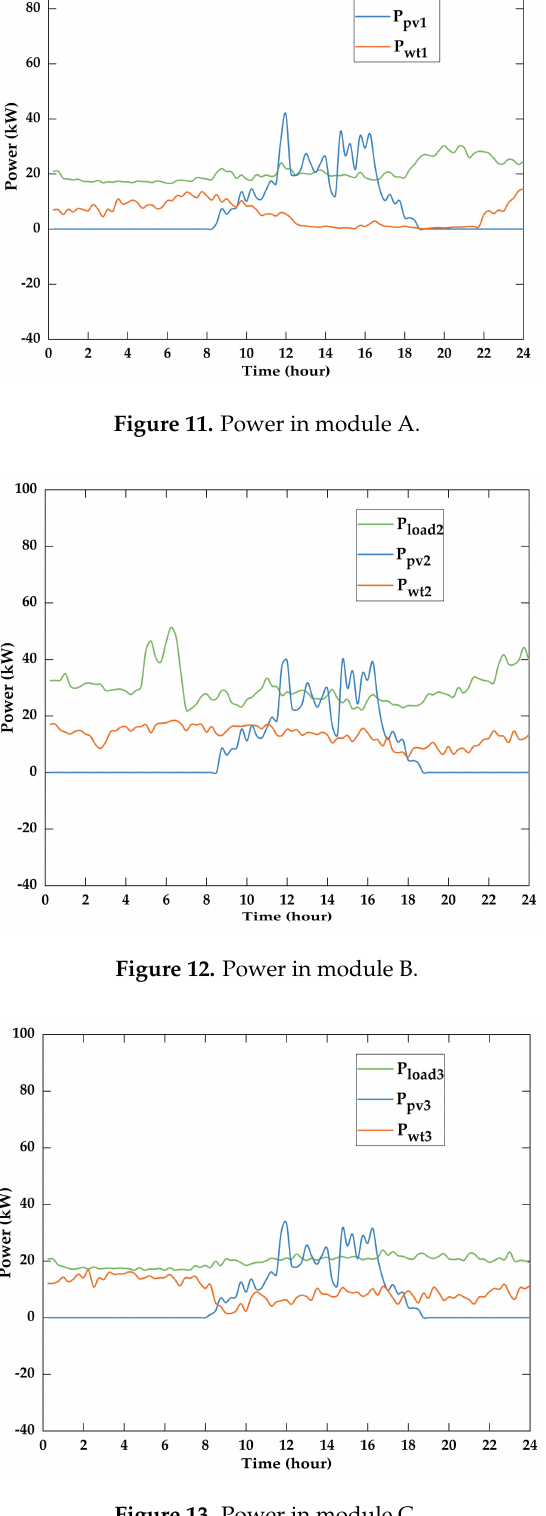
Figure 13. Power in module